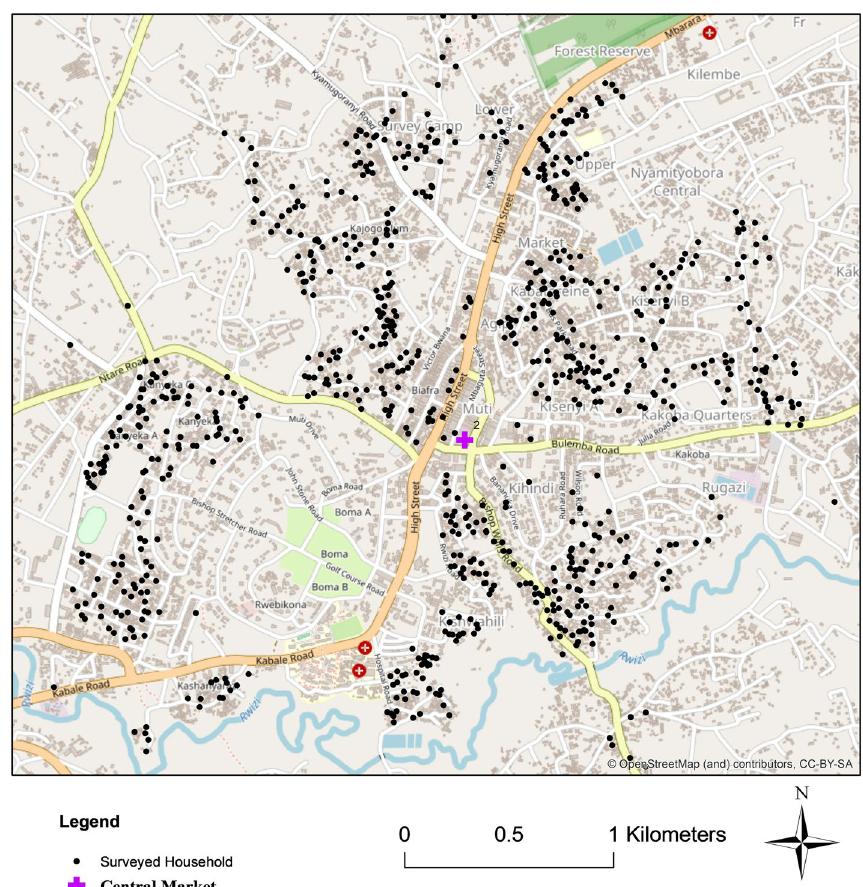
Fig. 4 Map of Mbarara, Uganda. Dots show the households surveyed. Source: Open street maps. Created by Mackay, H., April